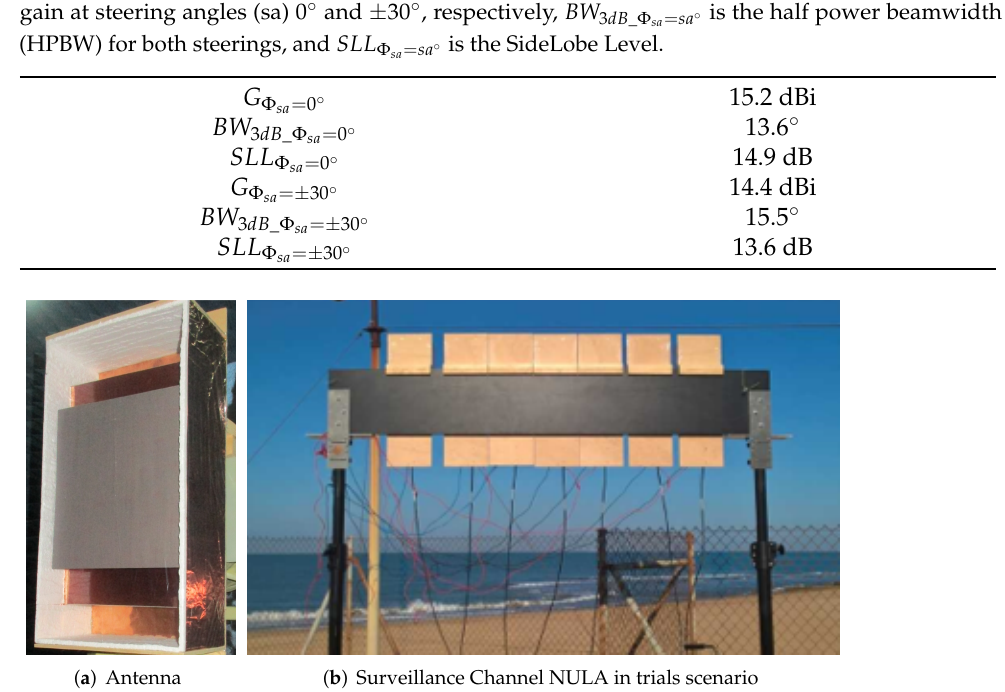
Figure 3. Prototype of single radiating element and back view of Non-Uniform Linear Array em- ployed for the surveillance channel in the trials